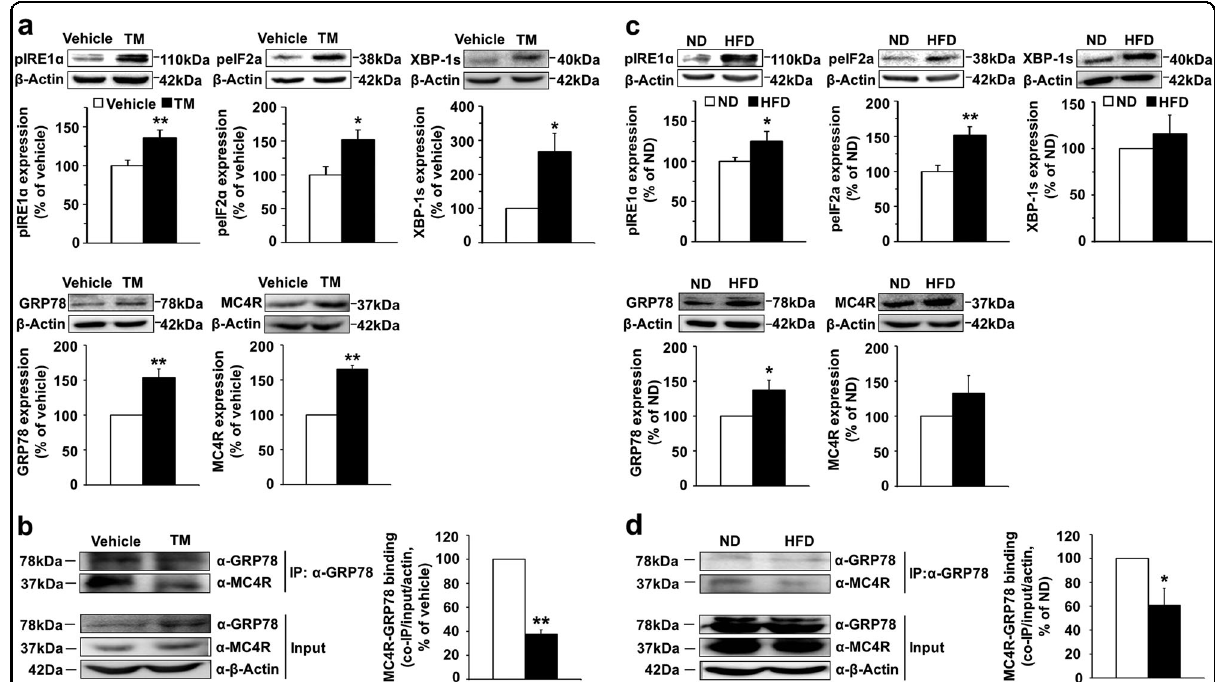
Fig. 4 Regulation of GRP78 and MC4R in the hypothalamus under ER stress. Mice were exposed to an ER stressor, and their brains were removed. Hypothalamic protein extracts were subjected to western blotting and coimmunoprecipitation. For acute ER stress conditions, 10-week-old male mice were injected with tunicamycin (TM) or vehicle (DMSO) into the lateral ventricle (i.c.v., TM 80 µg/3.2 µl, twice every 6 h) and were killed 12 h after the fi rst injection. For chronic ER stress conditions, 10 – 14-week-old male mice were fed a high-fat diet (HFD, 58.0% fat) or a normal diet (ND) for 20 weeks. The expression levels of ER stress marker proteins (pIRE1 α , peIF2 α , and XBP1s), GRP78, and MC4R in mice subjected to a acute ER stress (vehicle DMSO versus TM) or c chronic ER stress (ND versus HFD) were measured using western blotting. The interaction between GRP78 and MC4R was measured using coimmunoprecipitation under b acute ER stress or d chronic ER stress conditions. One-tailed Student ’ s t test for a – d : TM, n = 3 – 9 per group; HFD, n = 5 – 7 per group, * P < 0.05, ** P < 0.01 versus vehicle DMSO or ND group. The data are presented as the mean ±